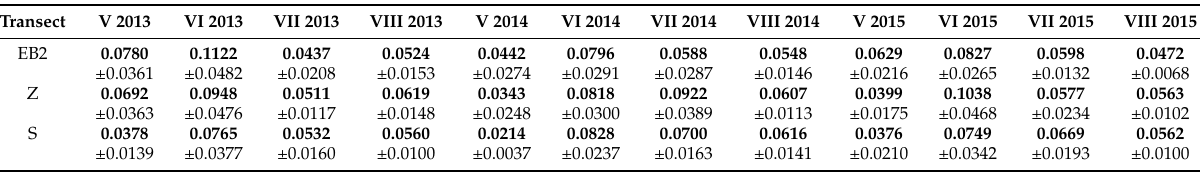
Table 5. The average (bold) and standard deviations of a p ( 443 ) along transects EB2, Z and S, derived from MODIS AQUA satellite data using the proposed